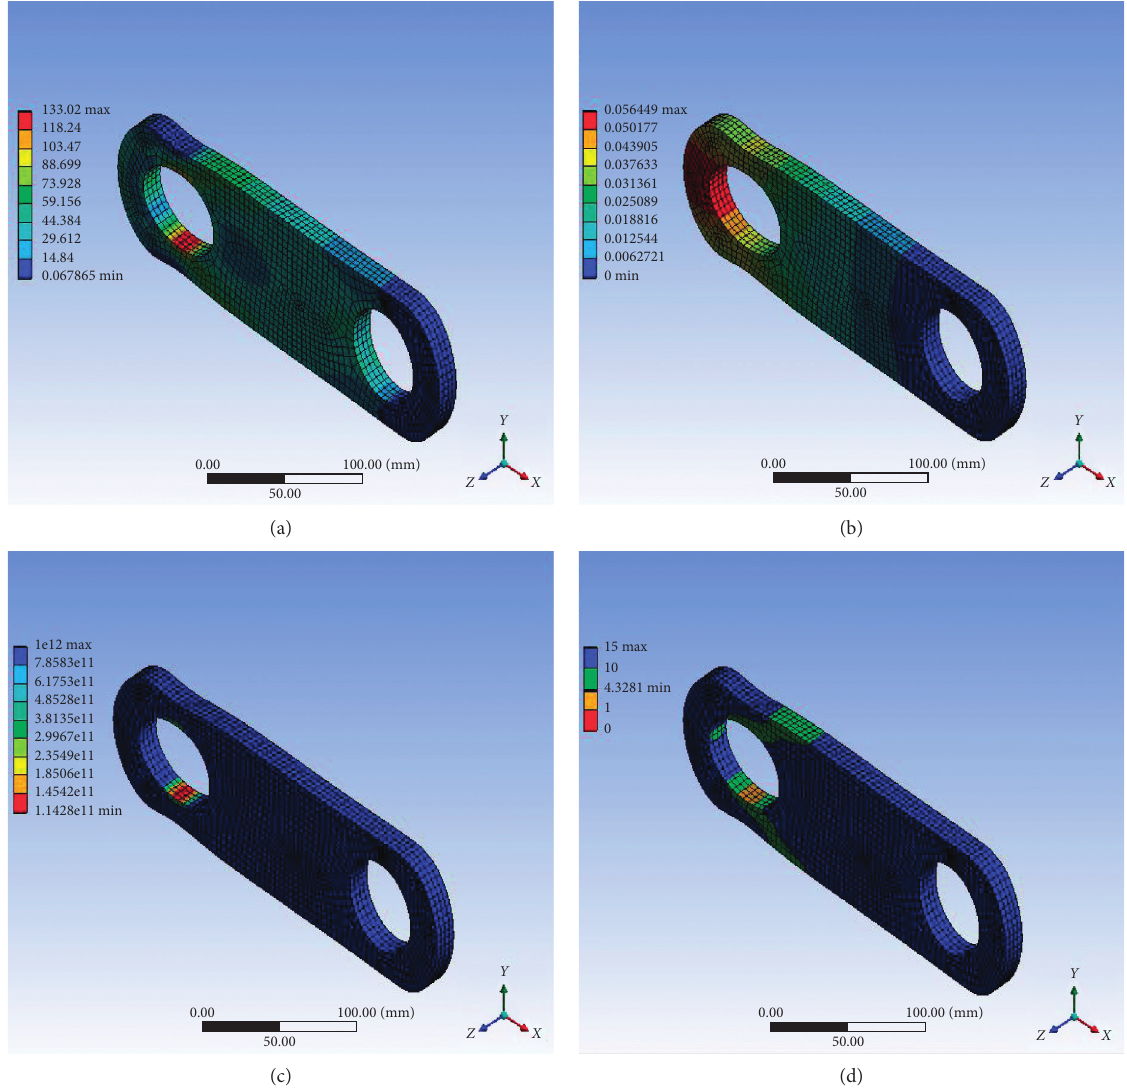
Figure 7: Simulation results for chain link without a modeled crack with neck radius 0mm ( X � 0): (a) equivalent stress, (b) deformation, (c) fatigue life, and (d) safety